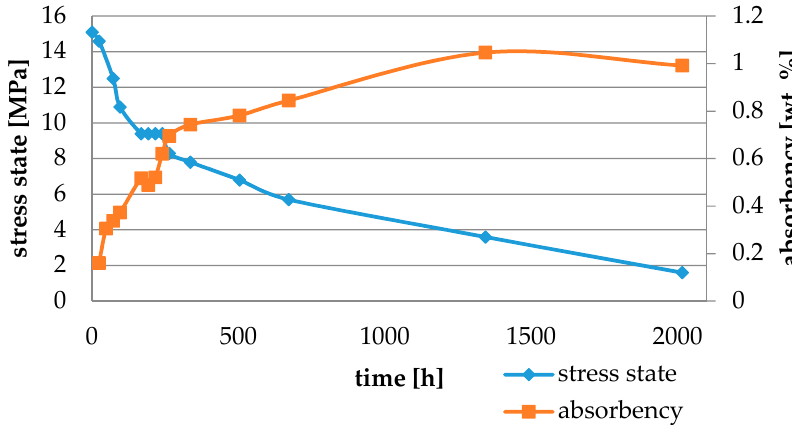
Figure 13. The influence of water sorption (2016 h water ageing) on the absorbency and contraction stress generated during the photopolymerization of SmartCem 2.